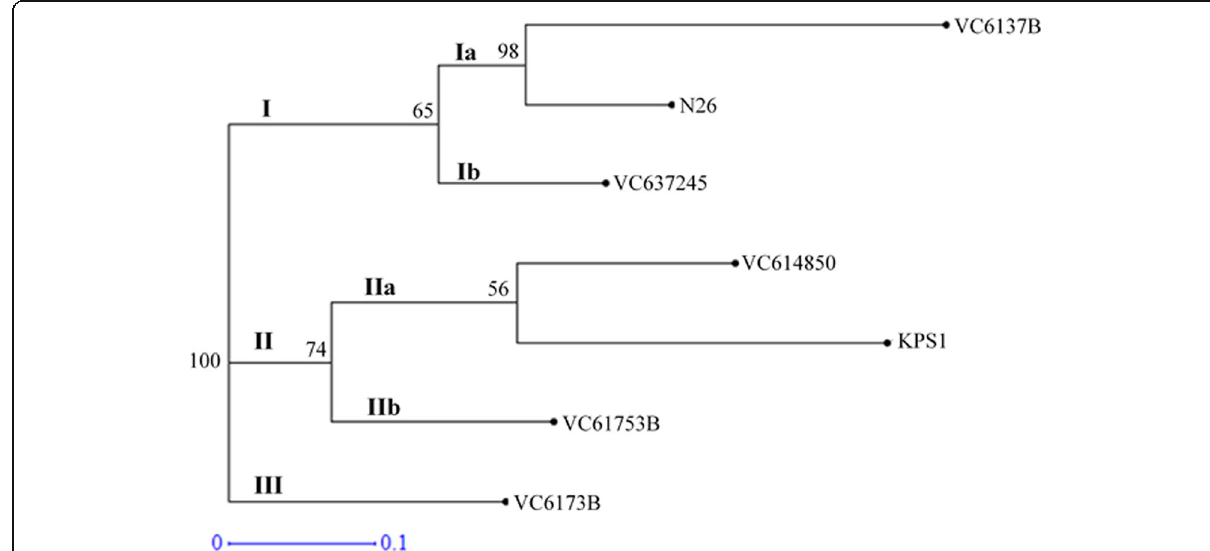
Fig. 3 A phylogenetic tree showing the genetic relatedness between the 7 genotypes based on the ten microsatellite markers study